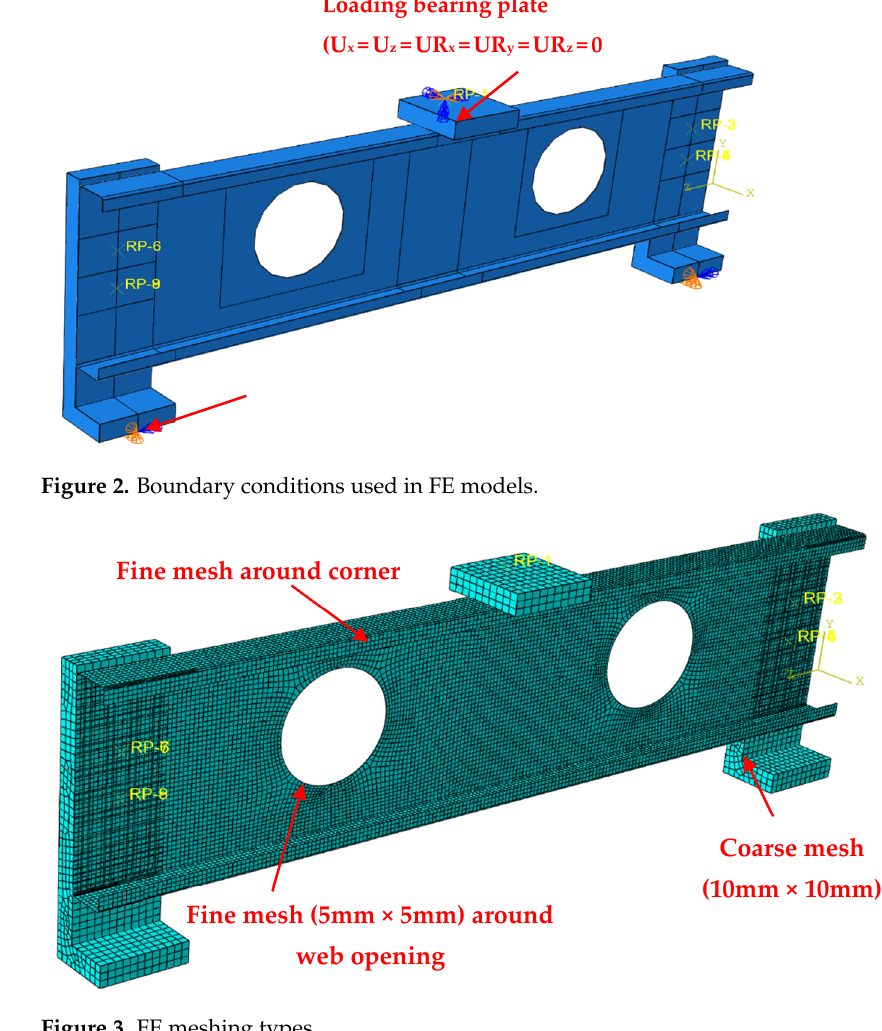
Figure 3. FE meshing types.